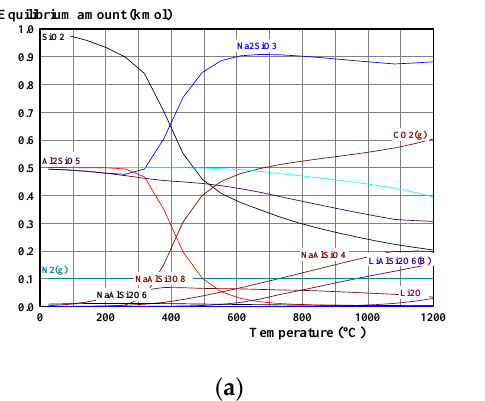
Figure 5. Equilibrium amounts versus temperature for chlorination of spodumene using ( a ) CaCl 2 , ( b ) Cl 2 and ( c ) KCl (data from HSC Chemistry 5.1 software). Figure 6. Equilibrium amounts versus temperature for carbonizing roasting of spodumene using Na 2 CO 3 by considering reactions reported in ( a ) Equation (12) and in ( b ) Equation (13), leading to the formation of Li 2 O and Li 2 CO 3 , respectively (data from HSC Chemistry 5.1 software).